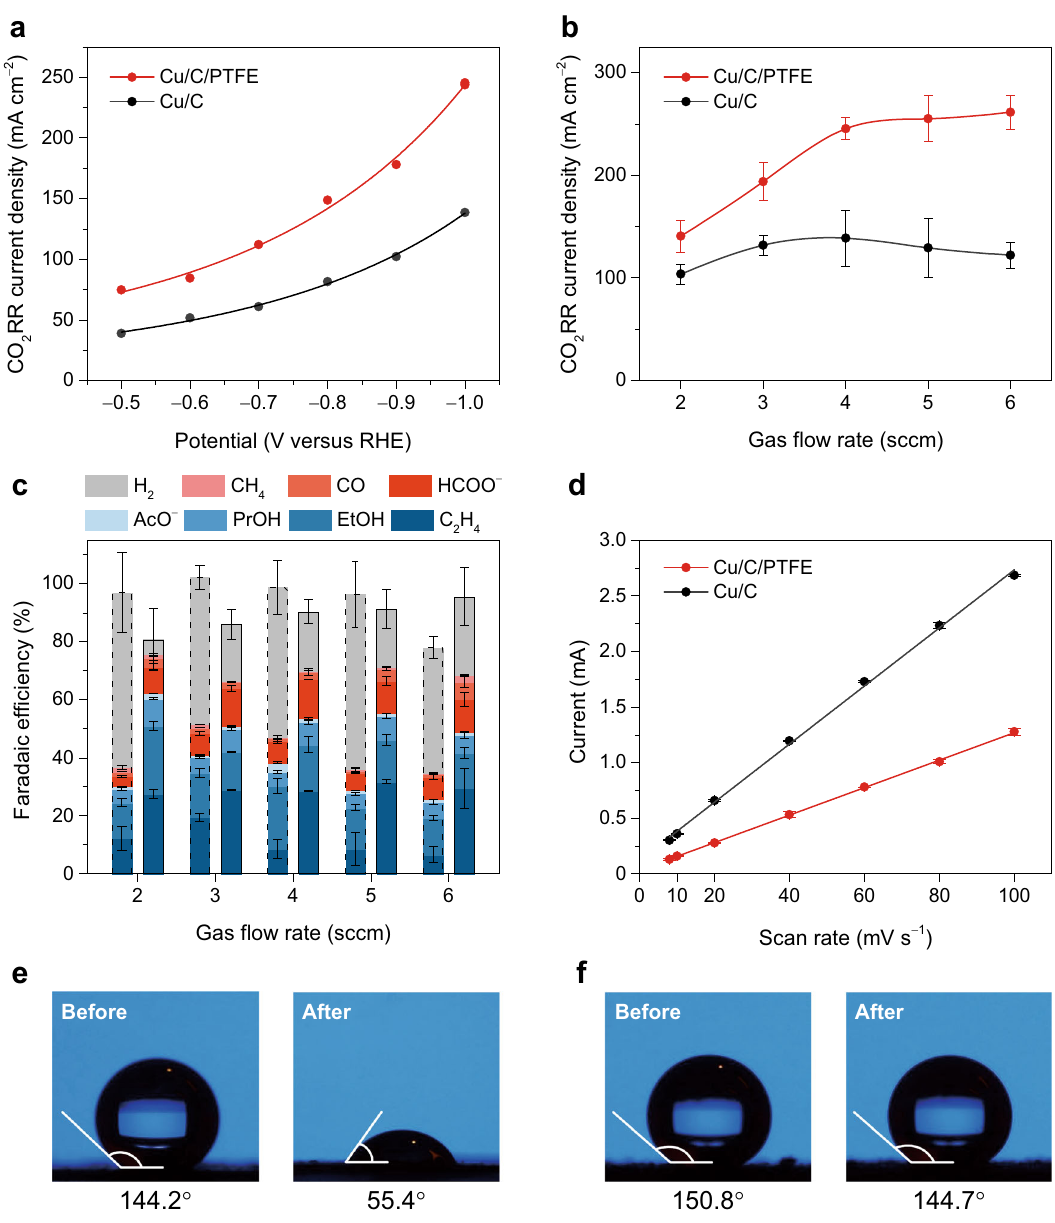
Fig. 3 Effect of hydrophobic microenvironment on the CO 2 RR in GDE cell. a Partial current densities for CO 2 RR on the Cu/C and Cu/C/PTFE electrodes at various potentials with a CO 2 gas fl ow rate of 4 sccm. b Partial current densities and c Faradaic ef fi ciencies for CO 2 RR on the two electrodes at − 1.0 V with various CO 2 fl ow rates. In c , the left column with dashed line frame at each fl ow rate is for the Cu/C electrode and the right column with solid line frame is for the Cu/C/PTFE electrode. d Double-layer charging current plotted against the CV scan rate for the two electrodes. e , f Photographs of contact angle measurements on the e Cu/C electrode and f Cu/C/PTFE electrode before and after CO 2 electrolysis at − 1.0 V for 2 h. The error bars represent the standard deviation of three independent